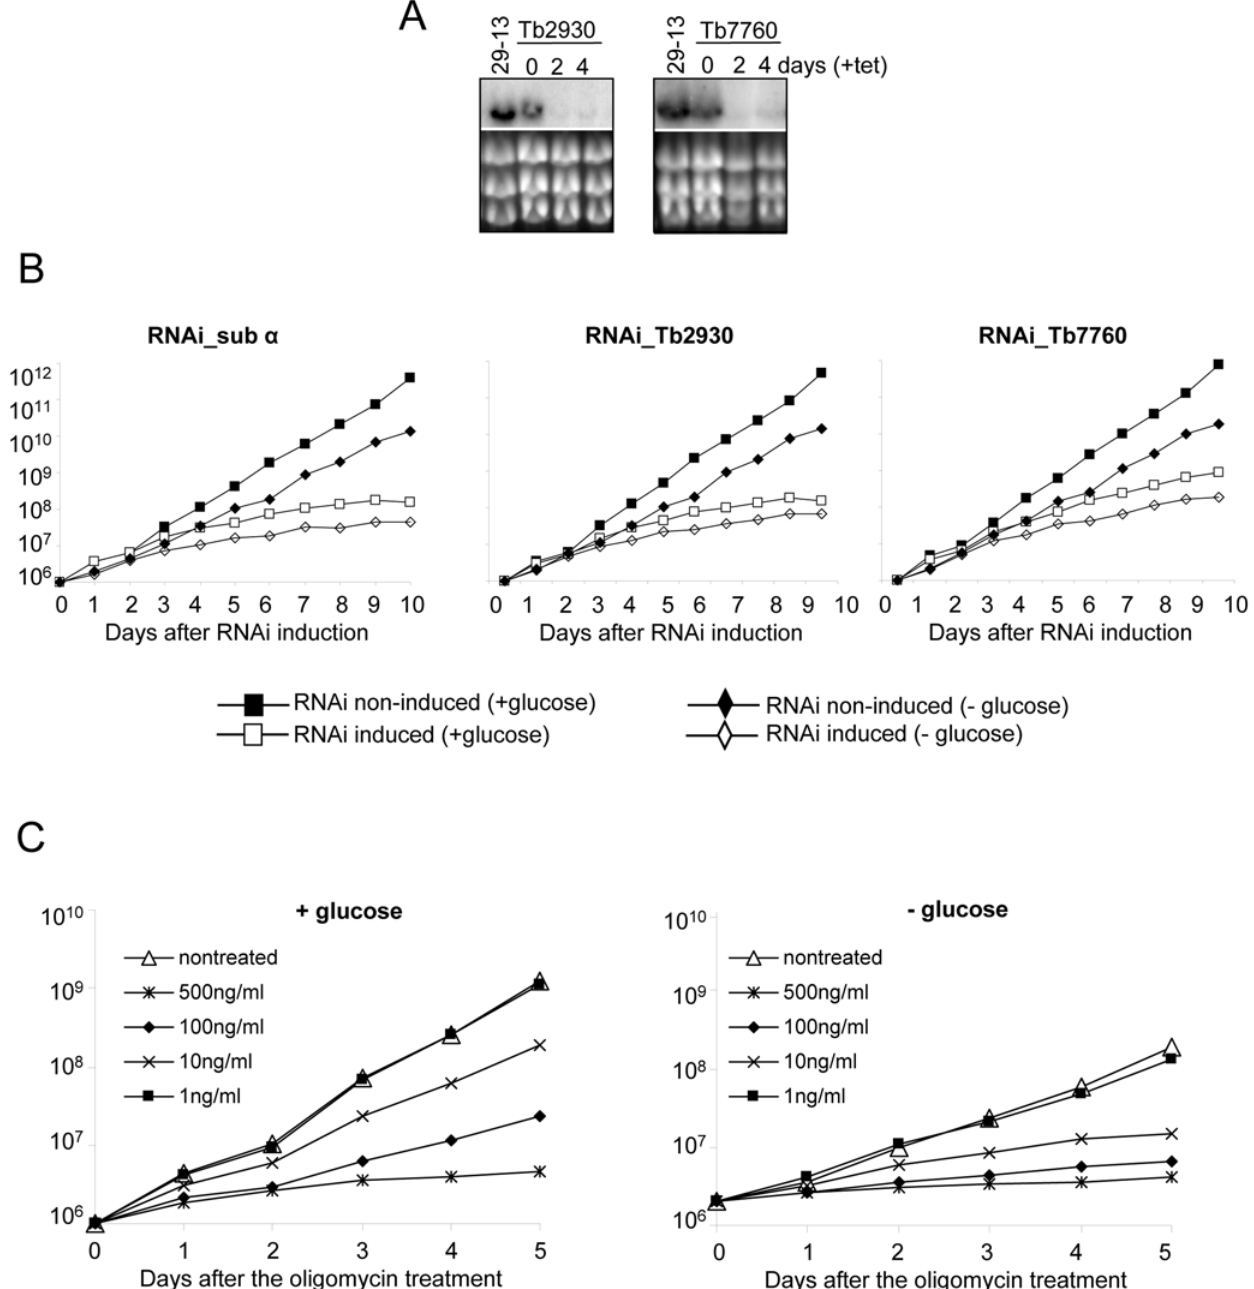
Figure 4. Subunits a , Tb7760 and Tb2930 are important for the invitro growth of procyclic parasites. (A) Northern analyses of the corresponding mRNAs for Tb7760 and Tb2930 RNAi cell lines with the days sampled indicated; and stained gels of rRNAs in the lower panel serving as loading controls. (B) Growth curves of uninduced and induced RNAi-sub a (left), RNAi_Tb2930 (middle panel) and RNAi_Tb7760 (right) cell lines in the presence or absence of glucose. Cells were maintained in the exponential growth phase (between 10 6 and 10 7 cells/ml) and cumulative cell number represents the normalization of cell density by multiplication with the dilution factor. (C) Growth of the 29-13 procyclic cell line in the presence or absence of glucose and in response to treatment with the indicated concentrations of oligomycin. Cells were cultured and their growth measured as described for (B).